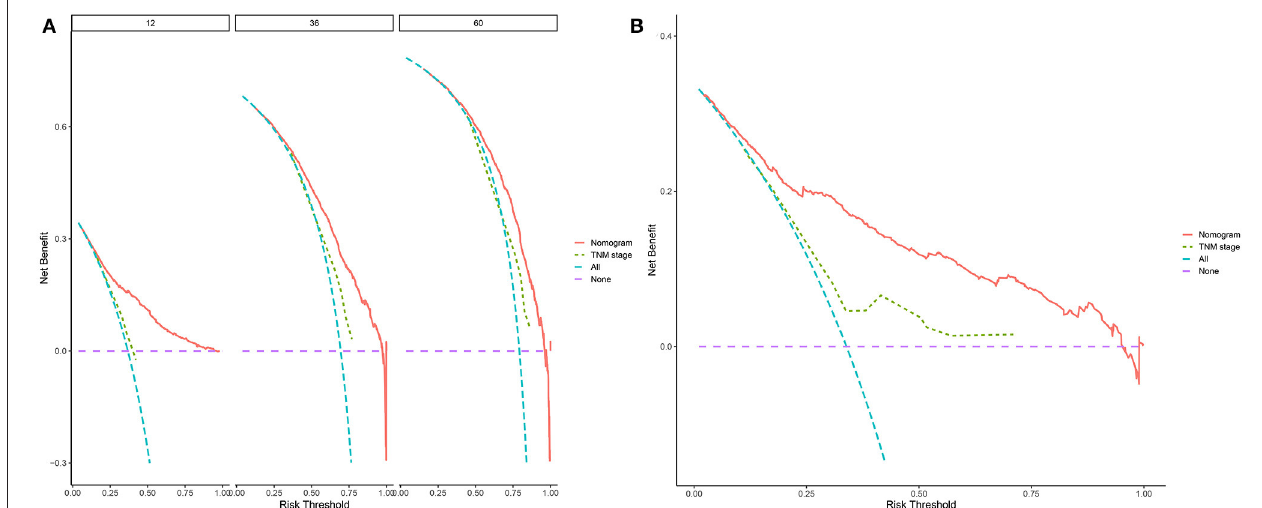
FIGURE 5 | Decision curves of the nomogram predicting OS in validation cohort (A) and external validation cohort (B) . The y-axis represents the net benefit, and the x-axis represents the threshold probability. The purple line indicates that no patients have died, and the blue line indicates that all patients have died. When the threshold probability is between 20 and 60%, the net benefit of the model exceeds all deaths or no